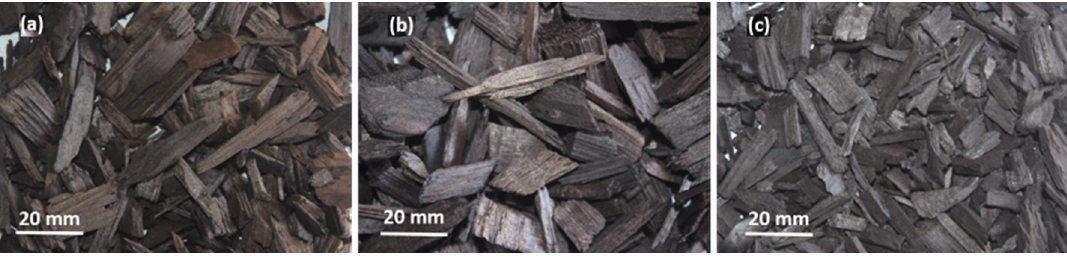
Figure 4. ( a ) Series 2: T4; ( b ) Series 2: T5; and ( c ) Series 2: T6, which presents a dark shade with brownish tones.